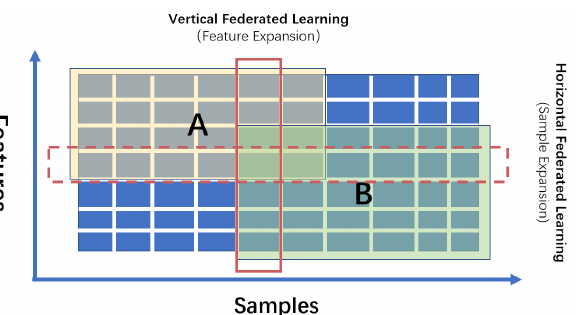
Figure 1. Two different kinds of federated learning from sample or feature expansions. A is the data owner of yellow rectangle area, and B is the data owner of green rectangle area.